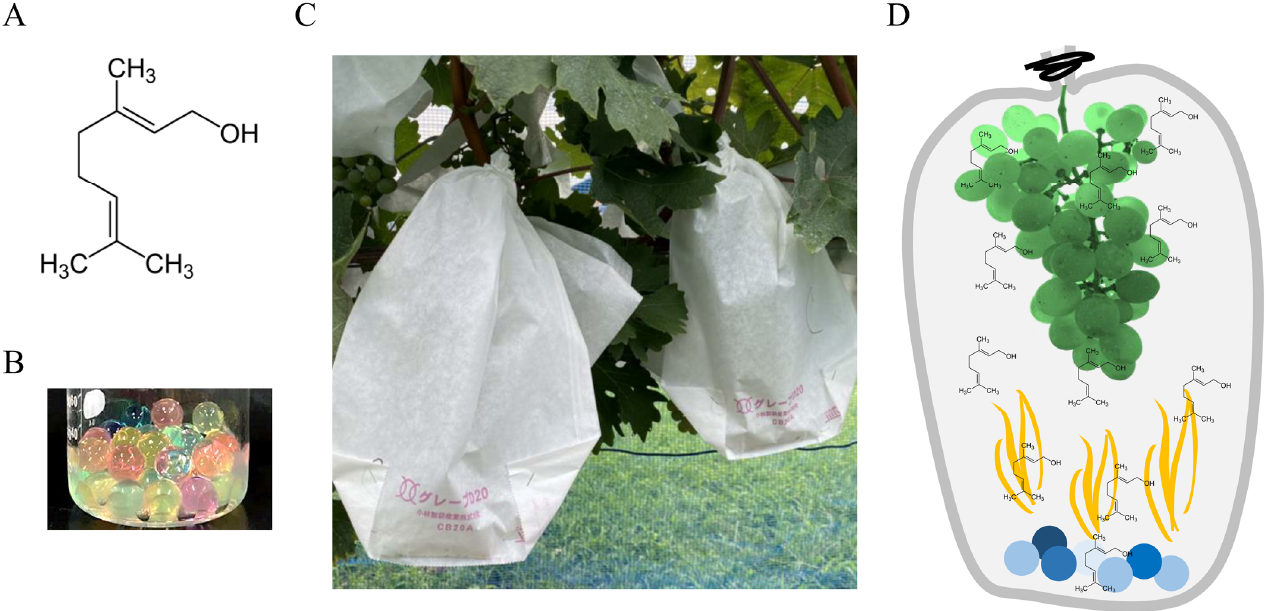
Figure 1. Experimental design of geraniol treatment to bunches of field-grown grapevines. ( A ) Chemical structure of geraniol. ( B ) Water-absorbing polymer treated with 10 nM geraniol. Polymer treated with diluted ethanol was used as control. ( C ) Photograph of geraniol-treated bunches of field-grown grapevines. Geraniol-treated or control polymer was added into a grape protective bag, respectively. The bunches were covered with the bags at véraison. Bunches were randomly collected every 10 days from véraison to harvest. ( D ) Schematic representation of geraniol treatment to bunches. Bagged bunches were exposed to geraniol vapor emitted by the geraniol-treated polymer in the bags.